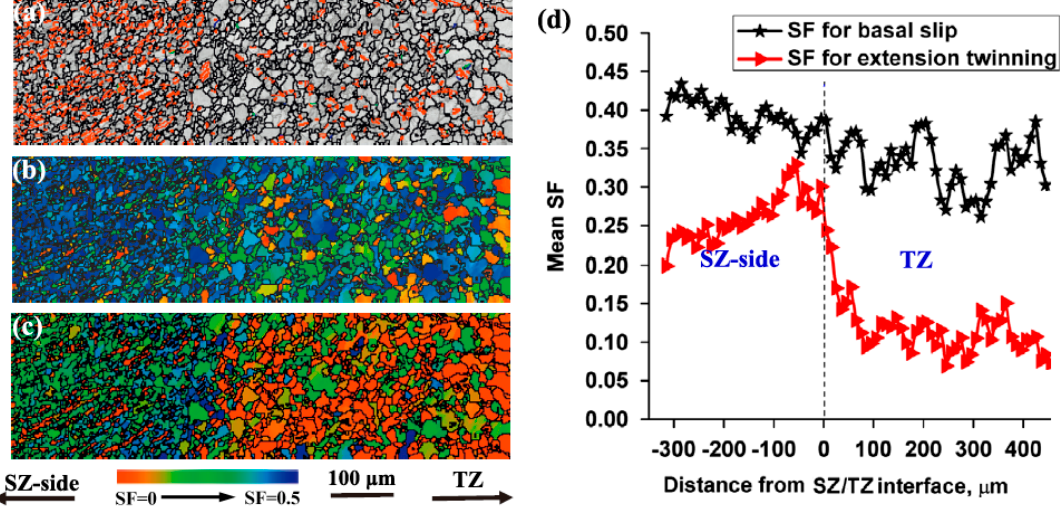
Figure 8. EBSD orientation maps of the SZ/TZ interface in FSW AZ31 alloy with a subsequent rolling strain of 2.5%: ( a ) band contrast map with extension twin boundaries indicated by red lines; SF map for basal slip ( b ) and extension twinning ( c ); and ( d ) variation of SF values as a function of the distance from the SZ/TZ interface [101].